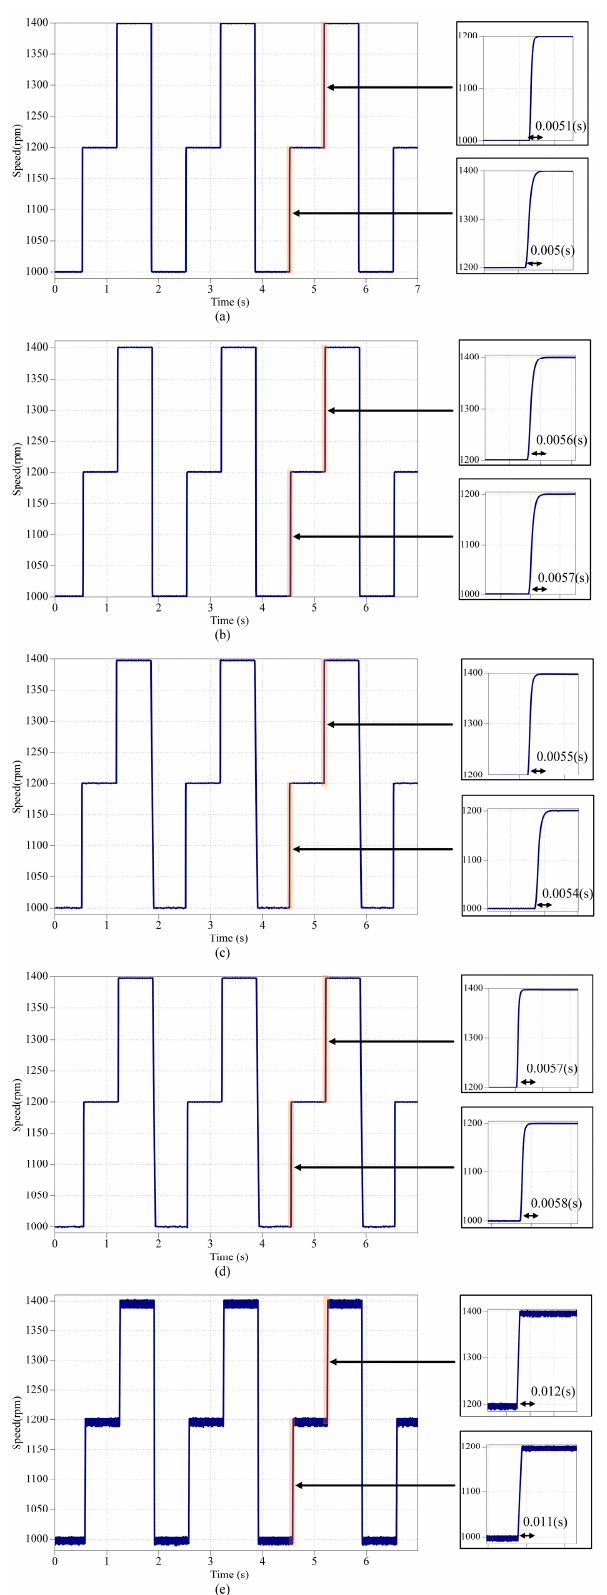
Figure 10. Experimental dynamic speed response of the PMSM under the no ‐ load condition and different ‐ step reference speed using HIL. ( a ) OLS ‐ FOSMC, ( b ) PR ‐ FOSMC, ( c ) RF ‐ FOSMC, ( d ) SVM ‐ FOSMC, ( e ) SMC.